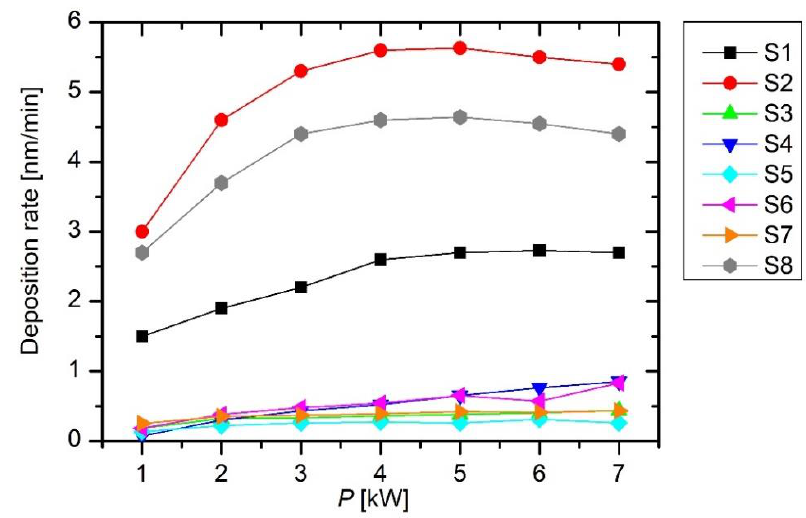
Figure 8. The deposition rate versus the discharge power in reactor loaded with samples.